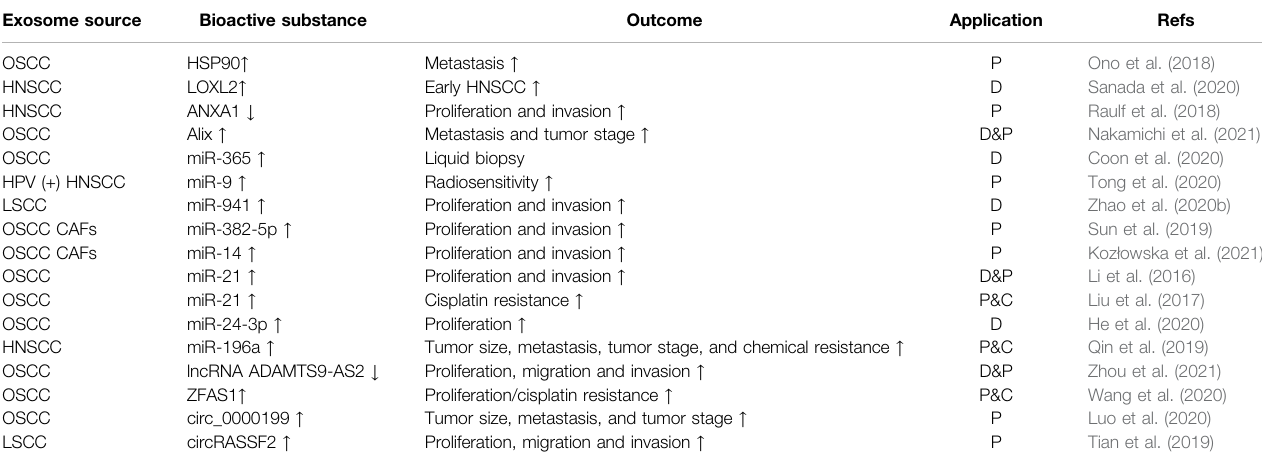
TABLE 3 | Biomarkers of HNSCC